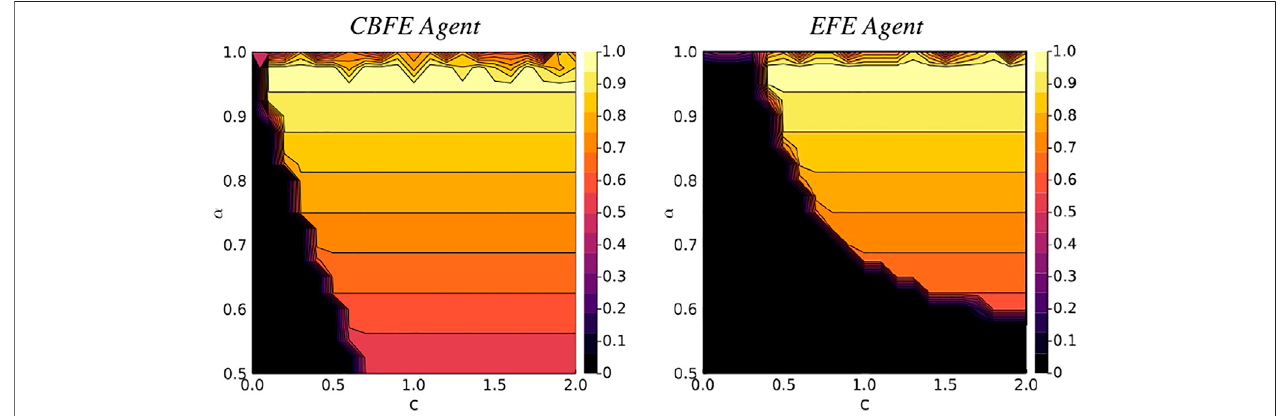
FIGURE 10 | Average reward landscapes for the Constrained Bethe Free Energy (CBFE) agent and the Expected Free Energy (EFE) agent.